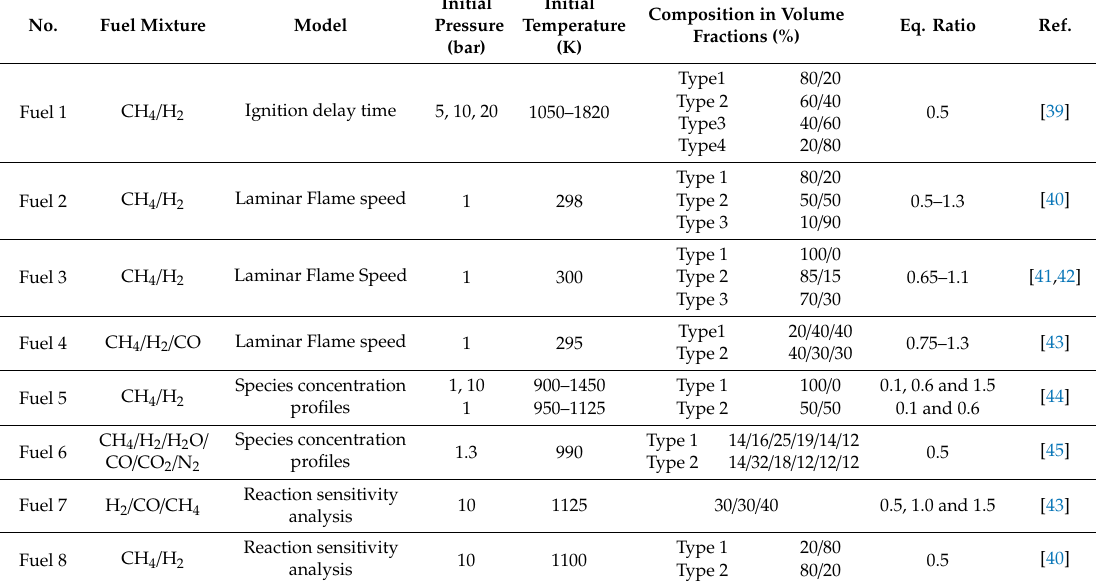
Table 2. Syngas blends used during this